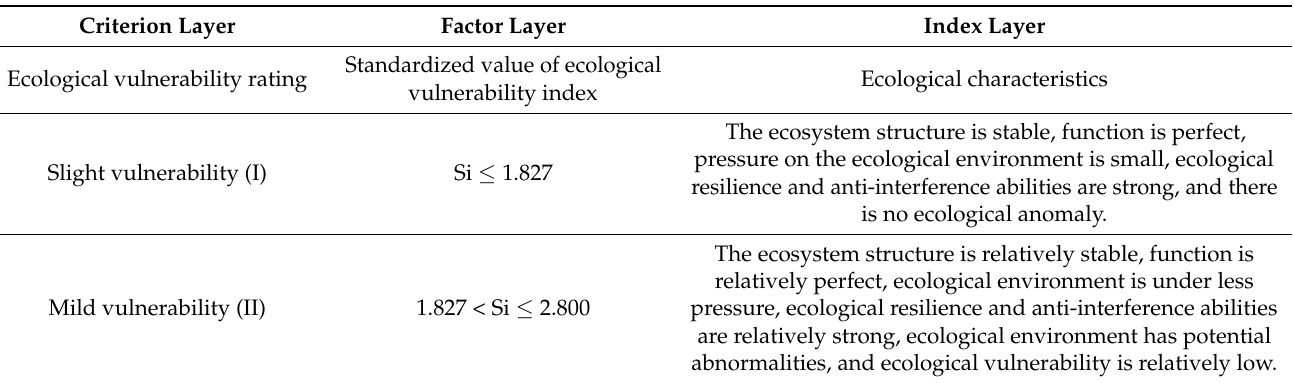
Table 2. Ecological vulnerability